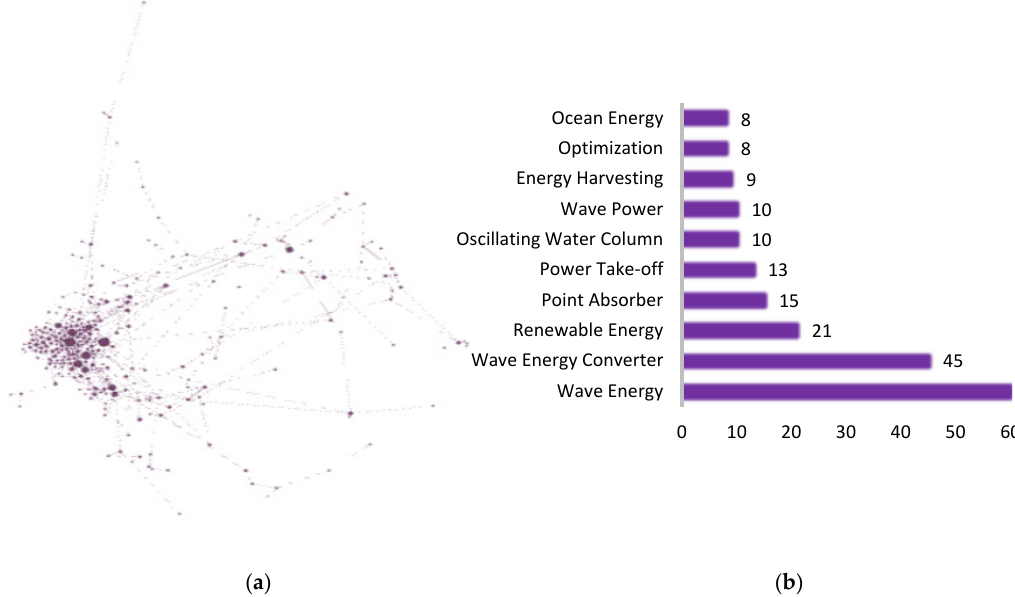
Figure 23 . Marine renewable energy: ( a ) manuscripts published, ( b ) keywords. Figure 23. Marine renewable energy: ( a ) manuscripts published, ( b )